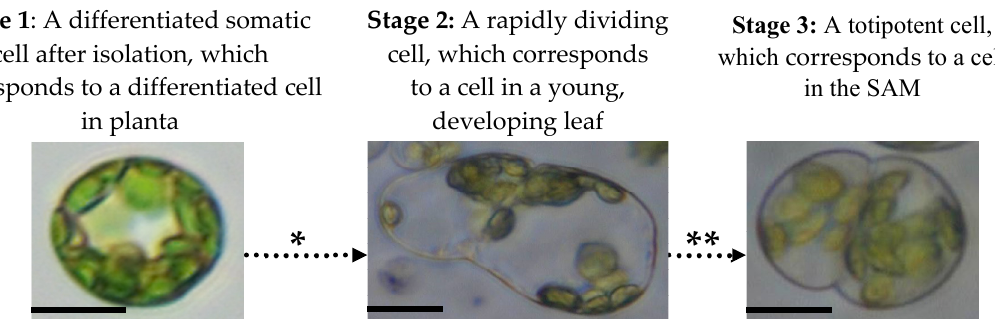
Figure 1. Mesophyll protoplast reprogramming to totipotency. There are three stages that mesophyll protoplasts follow during the activation of their cell division and transition to totipotency which are accompanied by various epigenetic, physiological and molecular processes. The following events occur during mesophyll protoplast reprogramming and cause dynamic changes in chromatin accessibility, hormonal responses and reactivation of the cell cycle: * Chromatin relaxation caused by specific histone and DNA chemical modifications, hormonal / ROS signalling (activation of auxin response and ROS generation / scavenging) and changes in the cell cycle gene expression. ** High-auxin environment leads to protein storage vacuole transition, histone hyperacetylation and cell cycle extension. Photomicrographs show protoplasts of Medicago sativa . All bars: 10 µ m.